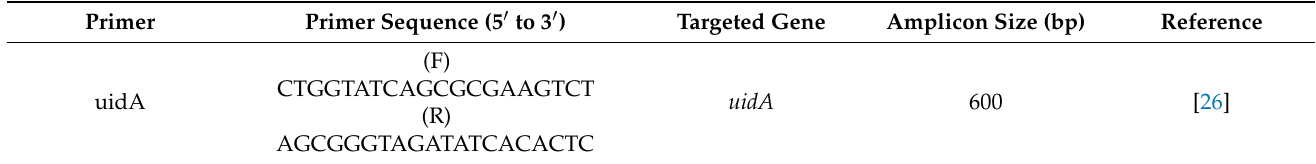
Table 1. Oligonucleotide primers used for the detection of E. coli. Primer Primer Sequence (5 (cid:48) to 3 (cid:48) ) Targeted Gene Amplicon Size (bp) Reference (F) CTGGTATCAGCGCGAAGTCT uidA 600 uidA (R) AGCGGGTAGATATCACACTC